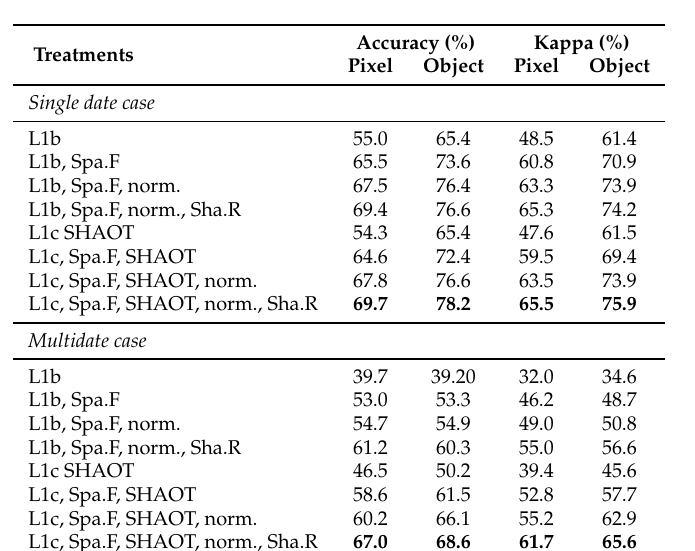
Table 6. Summary of the results from the comparison between two dates using 19 species with respect of each treatment.